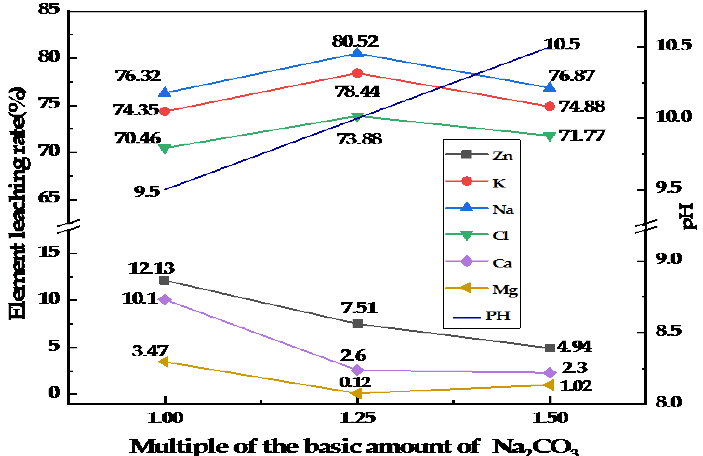
Figure 6. Leaching ratios of various elements with different Na 2 CO 3 additions at liquid–solid ratio of 4:1.